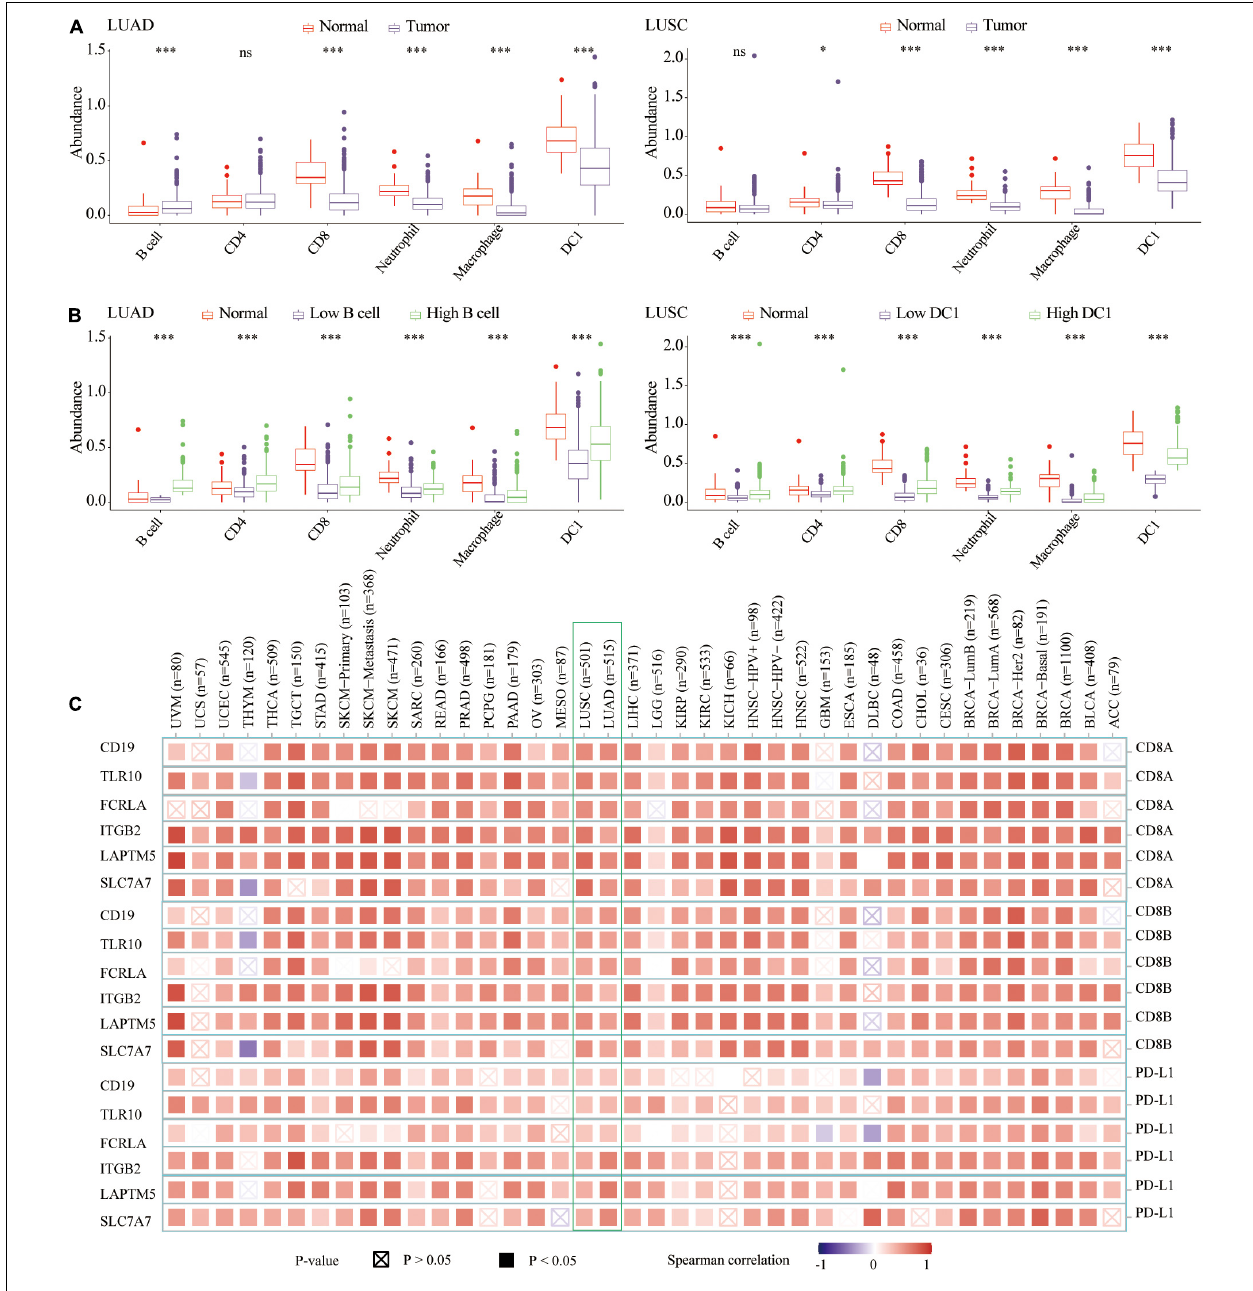
FIGURE 7 | The abundance of six types of TIICs among normal, low, and high B cell/DC1 groups. (A) Compared with normal tissues, the abundances of most TIICs were lower in lung cancer tissues. (B) For both LUAD and LUSC samples, compared with low B cell/DC1 groups, TIICs all increased significantly in the high B cell/DC1 group. (C) In TCGA pan-cancer, hub genes (CD19, TLR10, FCRLA, ITGB2, LAPTM5, and SLC7A7) were significantly related to CD8A, CD8B, and PD-L1. Red represents positive correlation, whereas blue represents negative correlation. The darker the color, the greater the correlation. Solid squares represent P < 0.05. * p < 0.05, *** p <